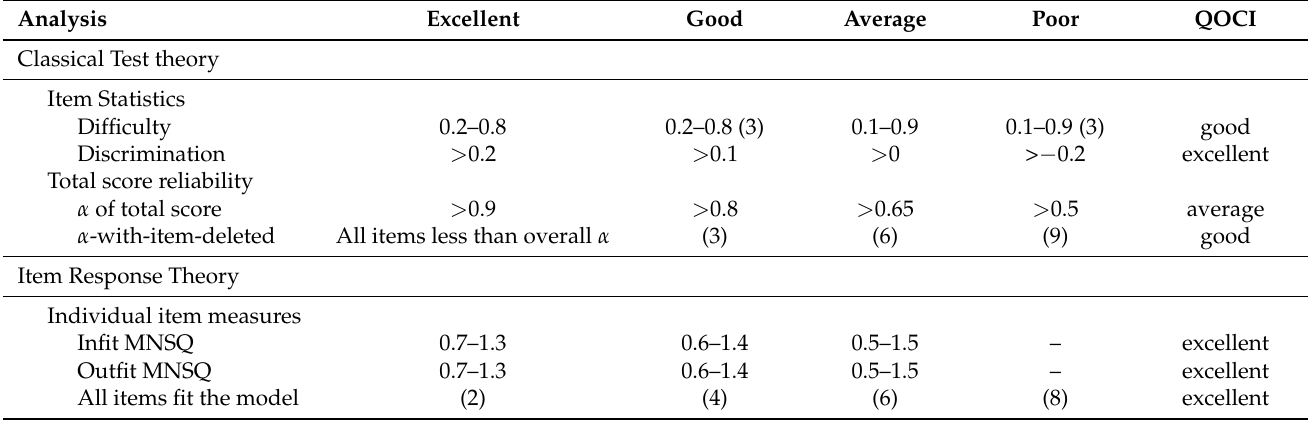
Table 4. Categorial judgment scheme and assignment rules for evaluating a concept inventory according to [70]. Values in parenthesis indicate the number of items that can fall outside of this rec- ommendation. The judgement of our concept inventory is presented in the last column labeled